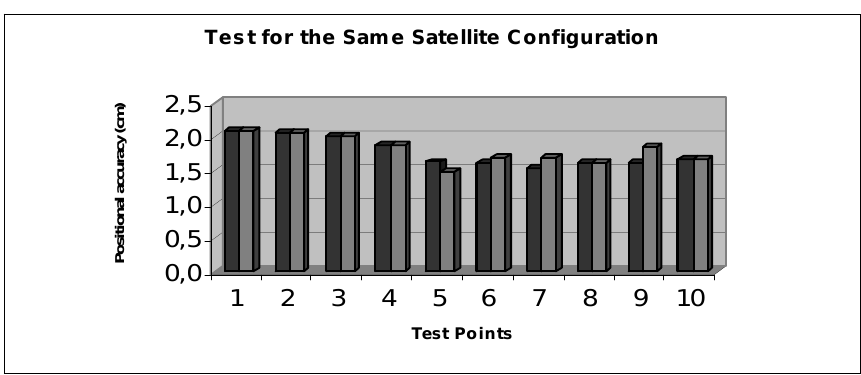
Figure 3 . Positional accuracies for Case 1.